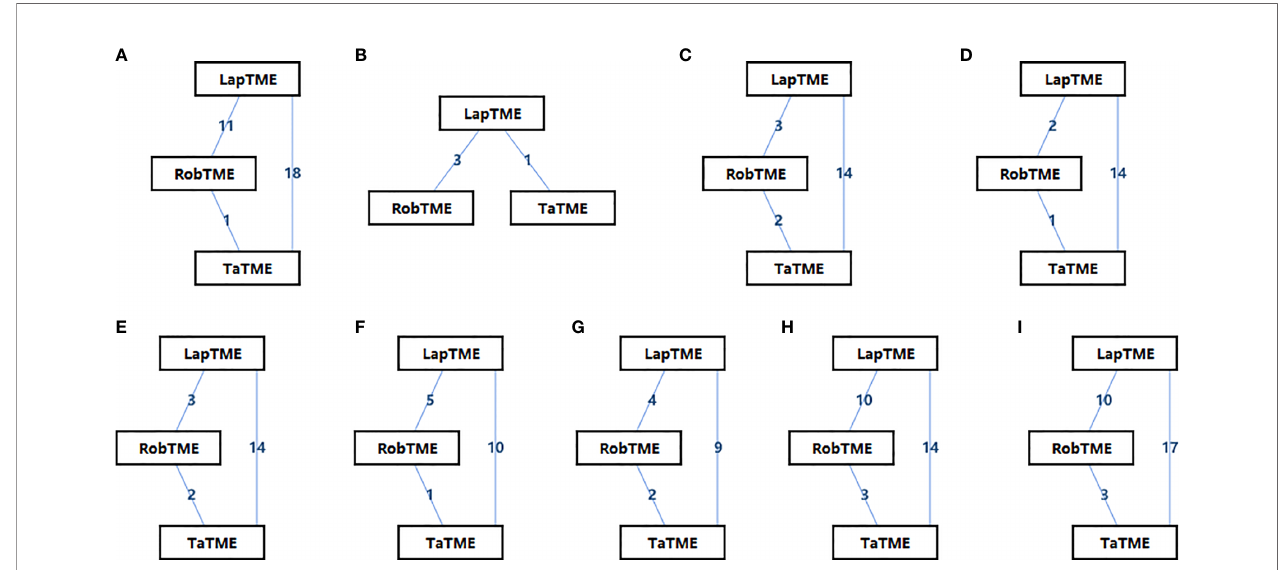
FIGURE 2 | Network diagrams of the eligible studies. (A) CRM involvement; (B) CRM involvement for ISR; (C) Complete mesorectum; (D) Near complete mesorectum; (E) Incomplete mesorectum; (F) DRM involvement; (G) Tumor distance to the CRM; (H) DRM distance; (I) Harvested lymph nodes.